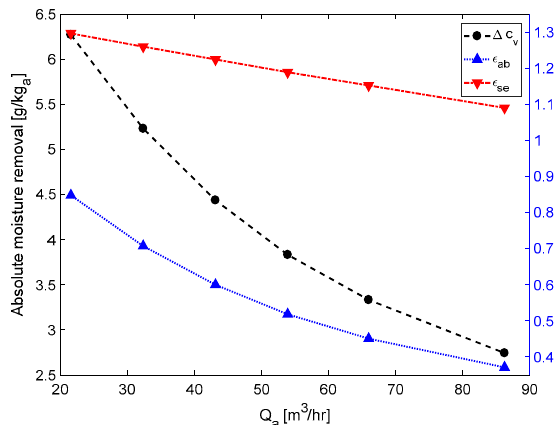
Figure 10. Effects of the airflow rate on the absolute moisture removal, absorption, and sensible effectiveness parameters.